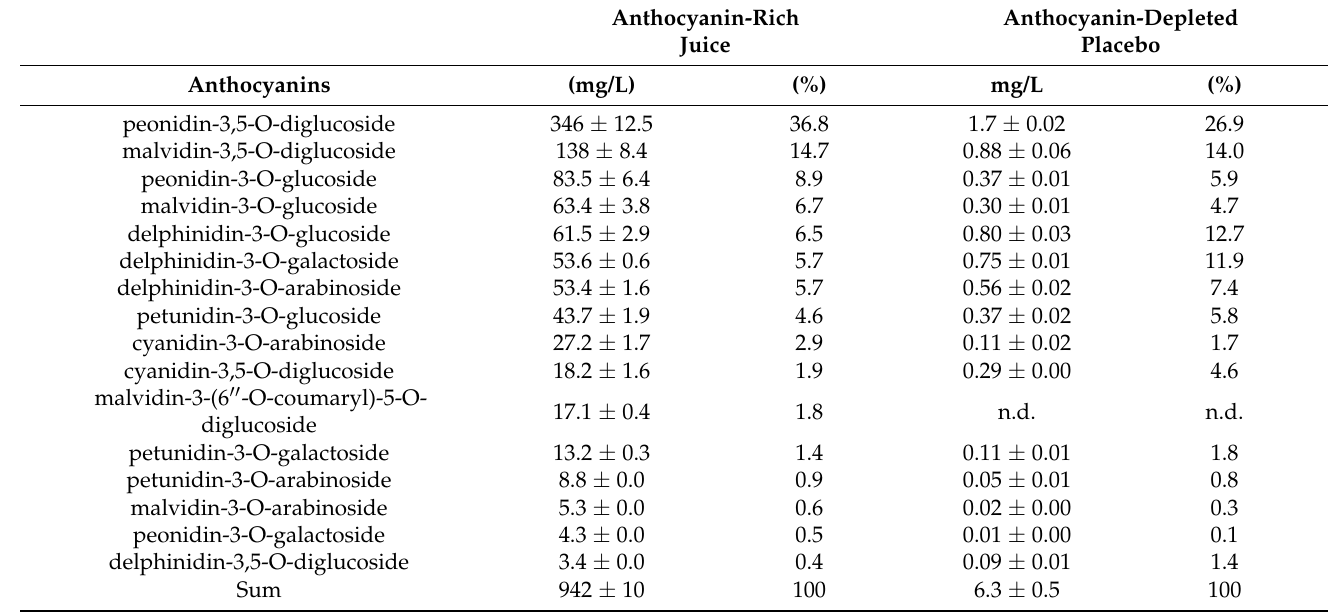
Table 1. Anthocyanin composition of the anthocyanin-rich juice and the anthocyanin-depleted placebo 1 . Anthocyanin-Rich Anthocyanin-Depleted Juice Placebo Anthocyanins (mg/L) (%)